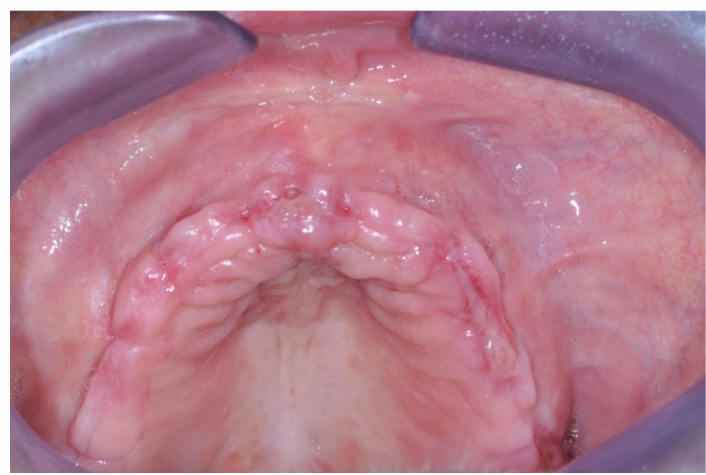
Figure 17. After 12 days, the area was healing with a secondary